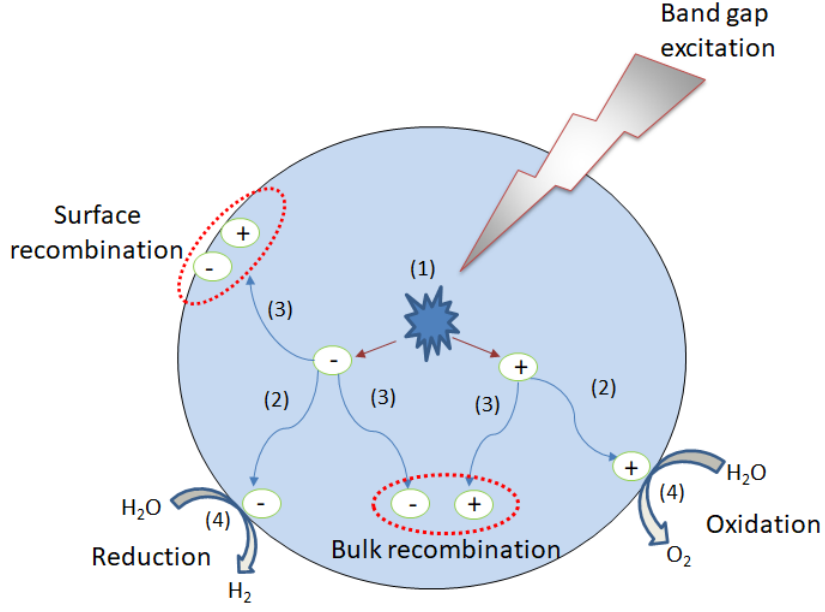
Figure 10. Schematic diagram of the charge carriers formation in a photocatalytic process. Adapted from reference